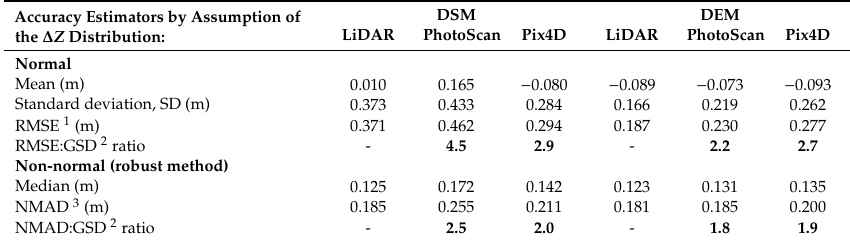
Figure 6. Histogram of the ∆ Z values (n = 587) for each model. Superimposed on the histogram are the expected normal distribution curves with mean and RMSE estimated from all the data (red). The Shapiro-Wilk test results are shown (if p -value ≥ 0.05, ∆ Z are normally distributed). Table 4. Accuracy measures of LiDAR based and UAV-derived models (checkpoints = The median error for the different models considered is between 10 and 20 cm, being in all cases